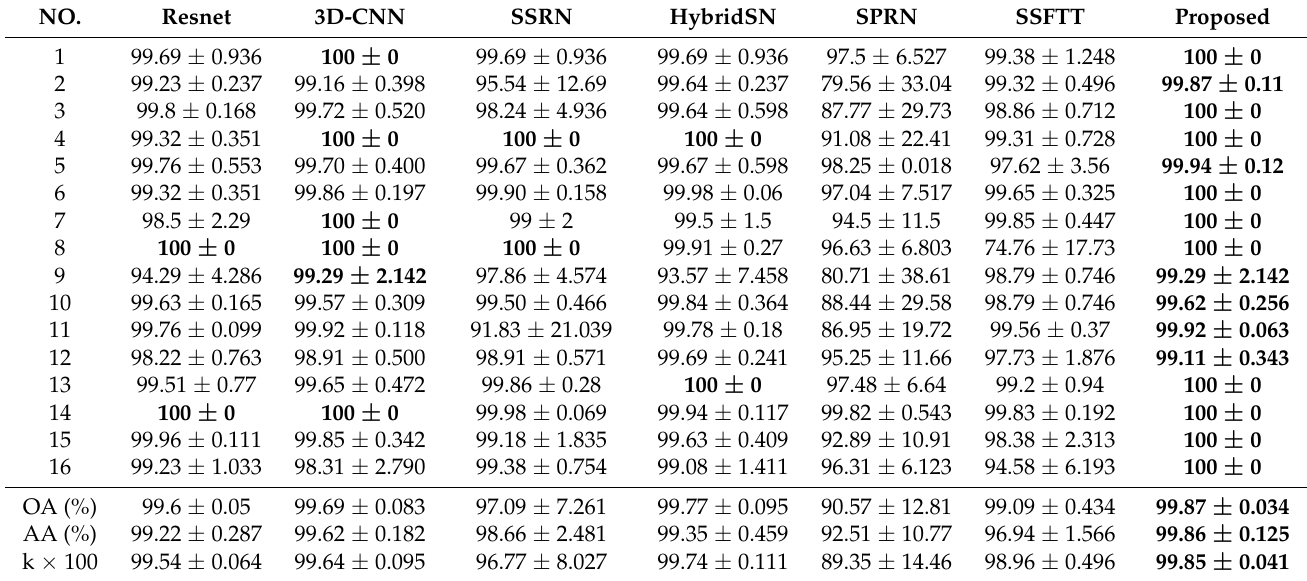
Table 5. Results of the various methods for IP using 30% training data (Highest performance is in